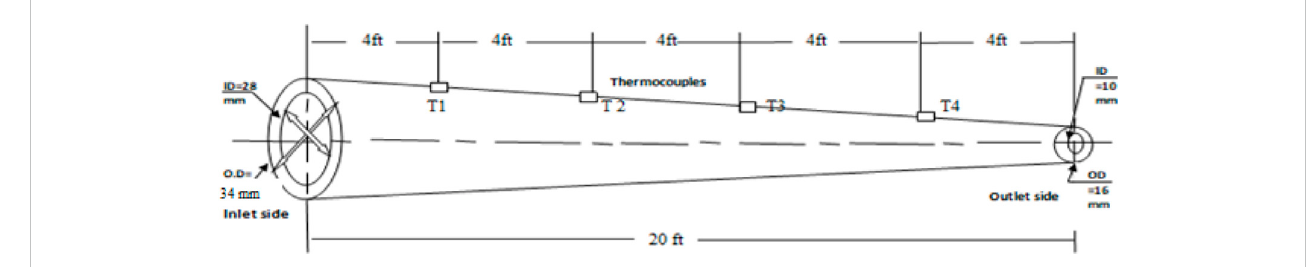
FIGURE 3 Receiver with a variable concentration